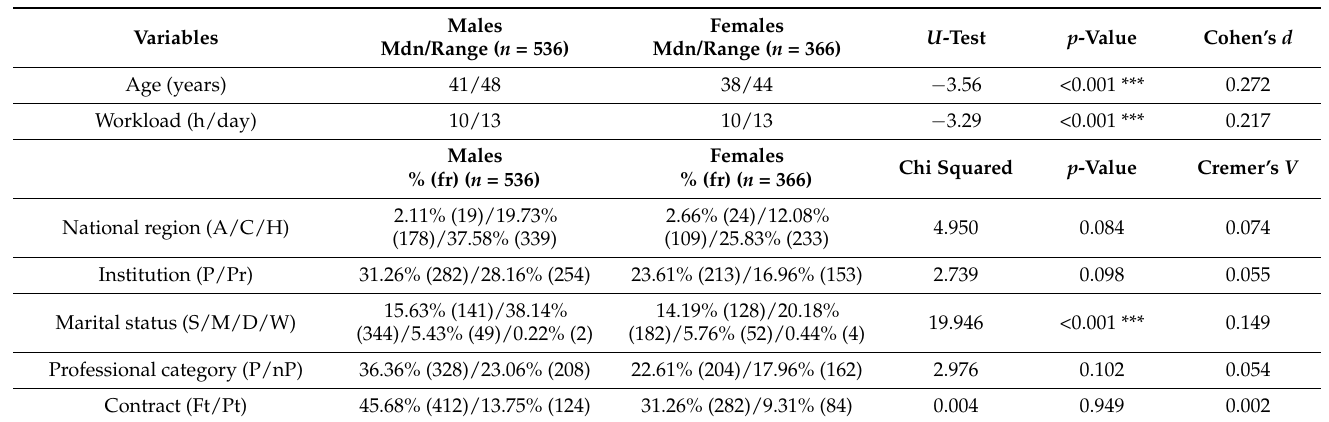
Table 1. Gender differences in sociodemographic variables.